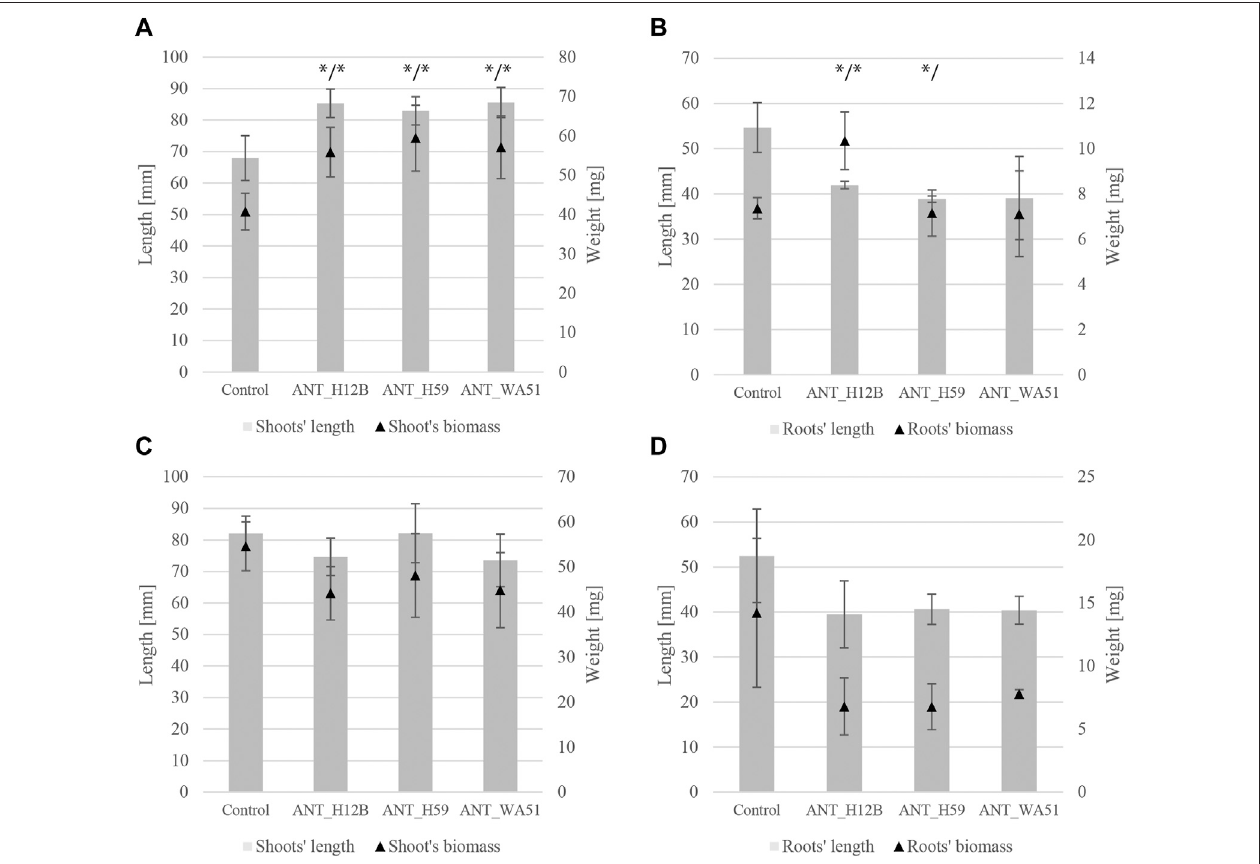
FIGURE4| Lengthandbiomassofshootsandrootsofplantsafter21 daysoftheexperiment.Panels (A,B) refertosoilbioaugmentationwithbacteria; (C,D) tothe application of their metabolites. Error bars represent standard deviations. */* - means statistical signi fi cance ( p < 0.05) for length and biomass; */means statistical signi fi cance ( p < 0.05) for length only.